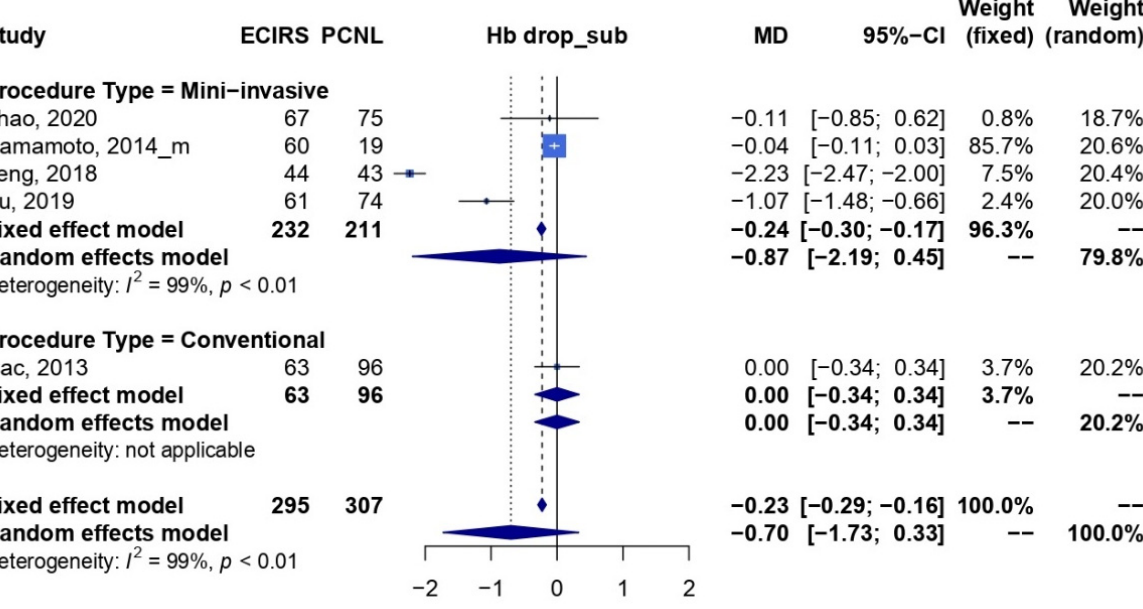
Figure A6. Subgroup analysis of outcome regarding hemoglobin drop. (Mini: [18,19,22,23]; Conven- tional: [21]).